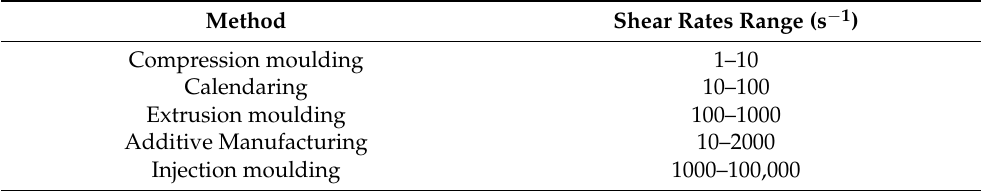
Table 1. Processing method and corresponding shear rate